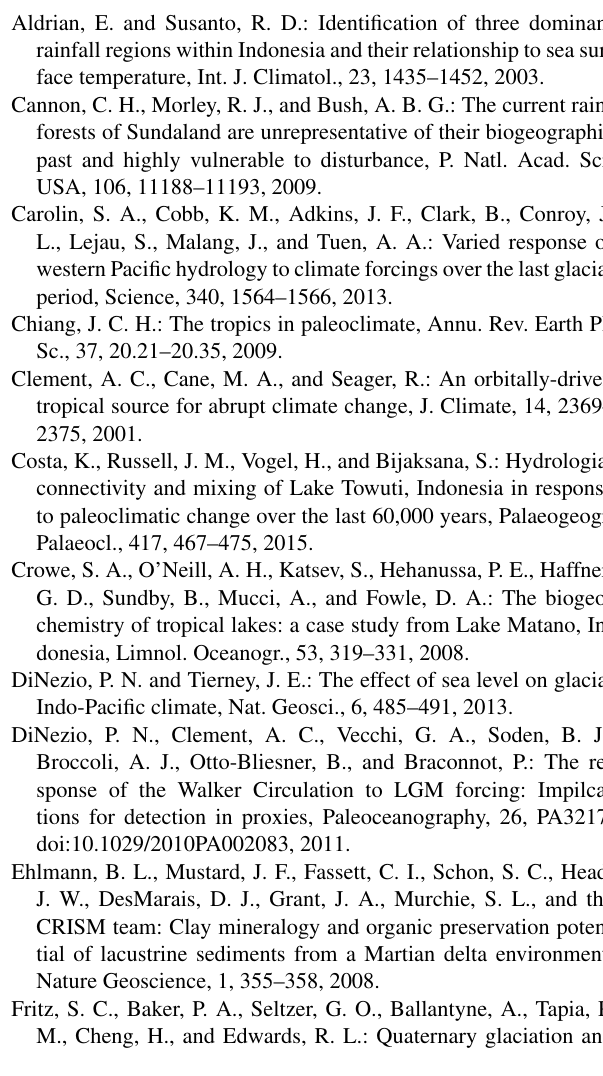
Figure 9. Magnetic susceptibility data from borehole logging of Hole 1B as well as MS data of cores 1B, 2A, and 3A. Yellow shading indicates correlative high magnetic susceptibility features in each site, whereas blue shading indicates correlative low sus- ceptibility features. The dashed line marks the interpreted bound- ary between Seismic Unit 1 and 2; note that this boundary appears younger in core 2A than at sites 1 and